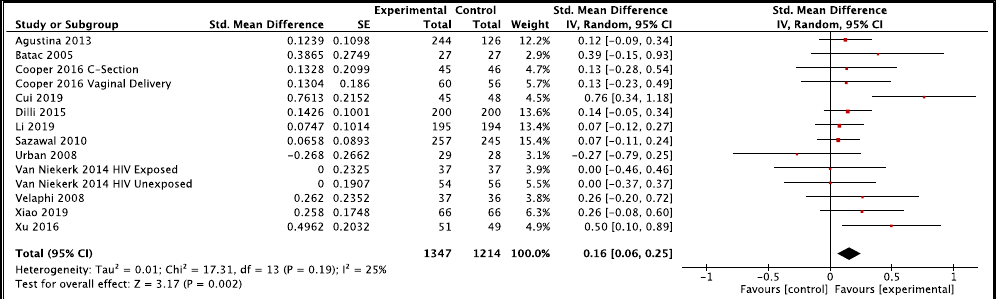
Figure 5. Effect of use of probiotics on height-for-age in children 0–59 months of age from low- and middle-income countries [21,27,33,36,39,50,70,83–85,91,92].